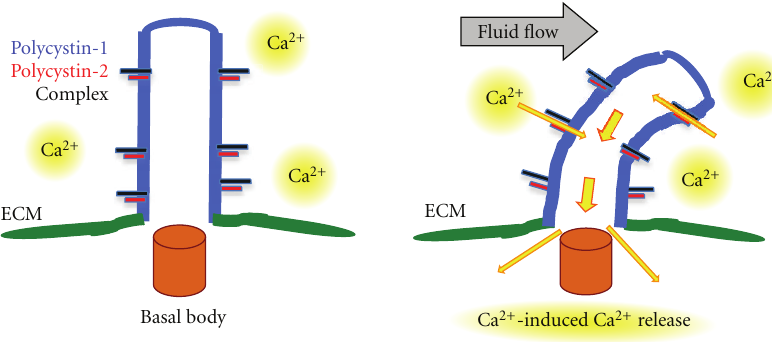
Figure 2: Mechanosensory cilia function involves calcium signal transduction. Mechanosensory cilia require functional polycystin complex. Fluid-flow-induced cilia bending will activate polycystin complex. This will mobilize calcium ions (Ca 2+ ) influx from the extracellular matrix (ECM) into the cell. Calcium-induced calcium release will further activate various calcium-dependent proteins to maintain proper